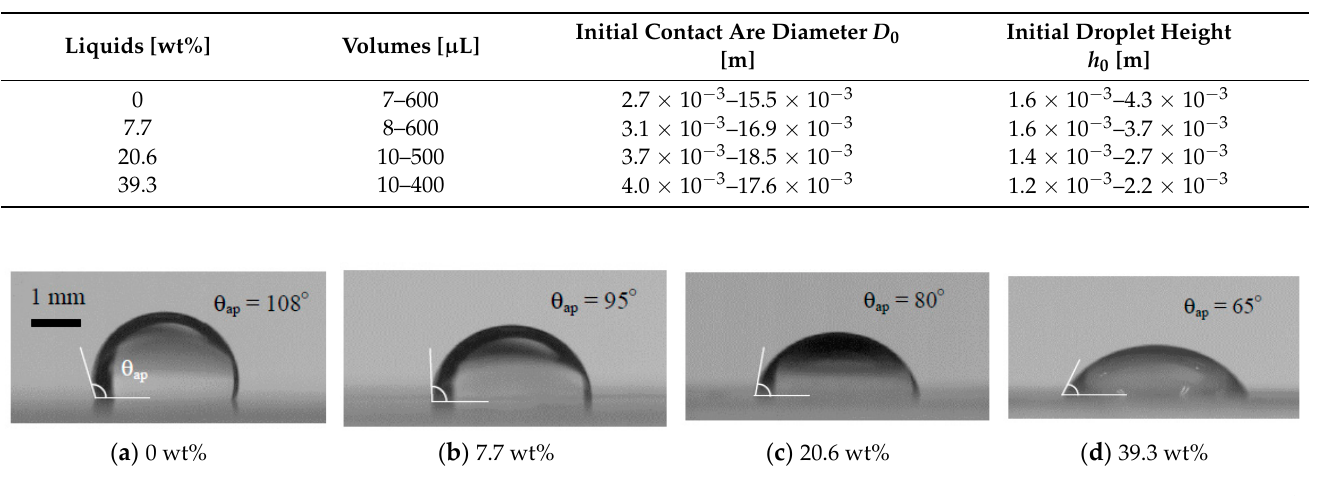
Figure 1. Schematic of ( a ) overall view of experimental apparatus and ( b ) view A in ( a ) where the geometrical parameters are defined. Table 1. Droplet volumes, initial contact area diameter and droplet height in each liquid used in sliding experiment.